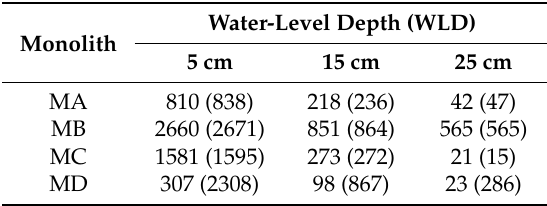
Table 2. Arithmetic means of the outflow and inflow rates calculated over the last 30 min of the stages for each prescribed water-level depth. Inflows are in parentheses. The rates are in mL · min − 1 · m − 1